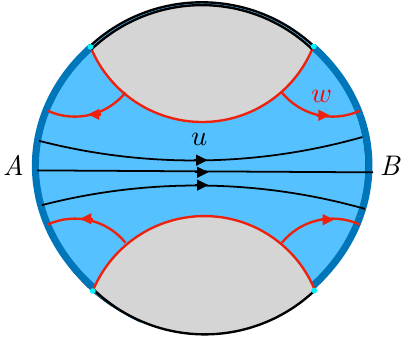
Figure 20 . An example of vector (cid:12)elds u and w